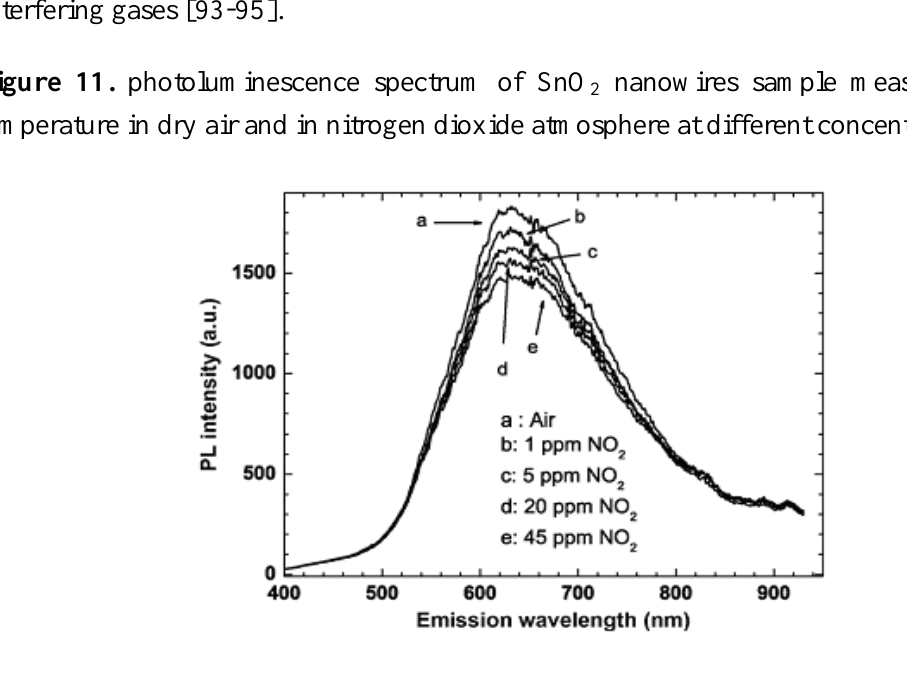
nanowires sample measured at room 2